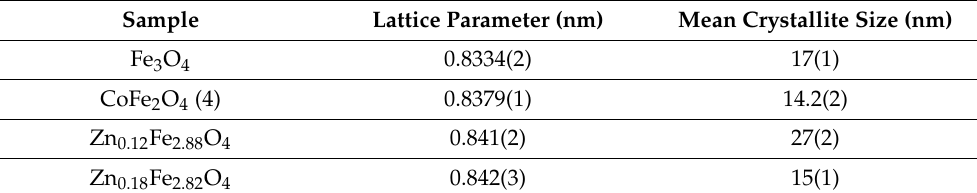
Table 1. Lattice parameters and nanocrystallite sizes.